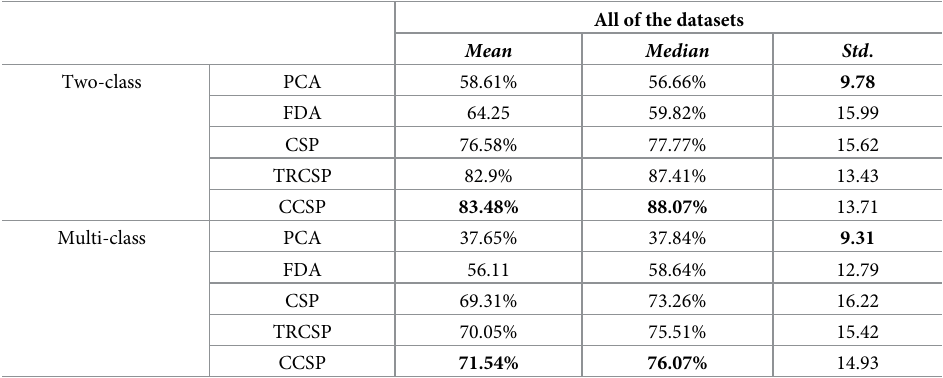
Table 1. Mean, median and standard deviation (std.) for two and multi-class problem (Best values are in